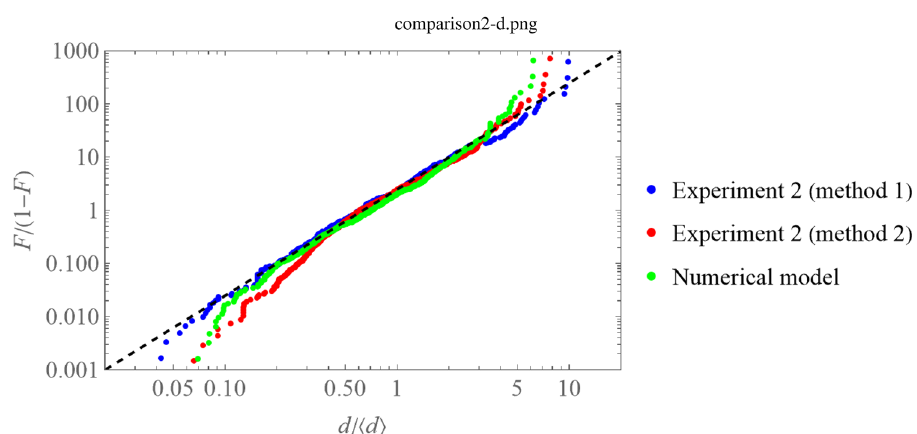
Figure 5. Function F /( 1 − F ) , where F is the cumulative distribution function of the corresponding stochastic variable x = d / � d � (normalized fiber diameter). The experimentally measured values (620 data) are compared to the results of the numerical simulation according to the proposed model (see